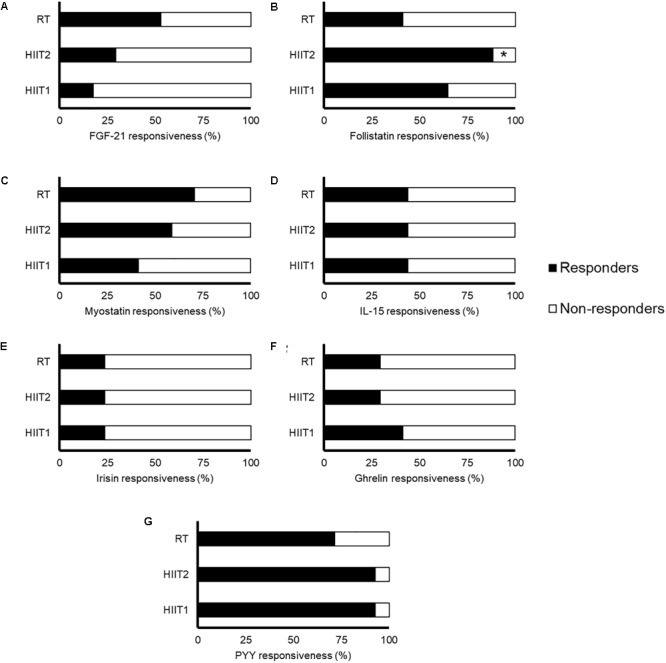
Rate of responsiveness of fibroblast growth factor-21 (FGF-21) (A), follistatin (B), myostatin (C), interleukin (IL)-15 (D), irisin (E), ghrelin (F), and peptide YY (G) in response to a session of high-intensity interval training with short (HIIT1) or long intervals (HIIT2), or a resistance training (RT) session. Responsiveness was determined as a positive change greater than the smallest worthwhile change (calculated for each molecule as twice the typical error of measurement and expressed as a percentage). All molecules were measured in 17 subjects except for IL-15 and PYY, which were measured in 9 and 14 subjects, respectively. Significantly different from RT: ∗p < 0.05.